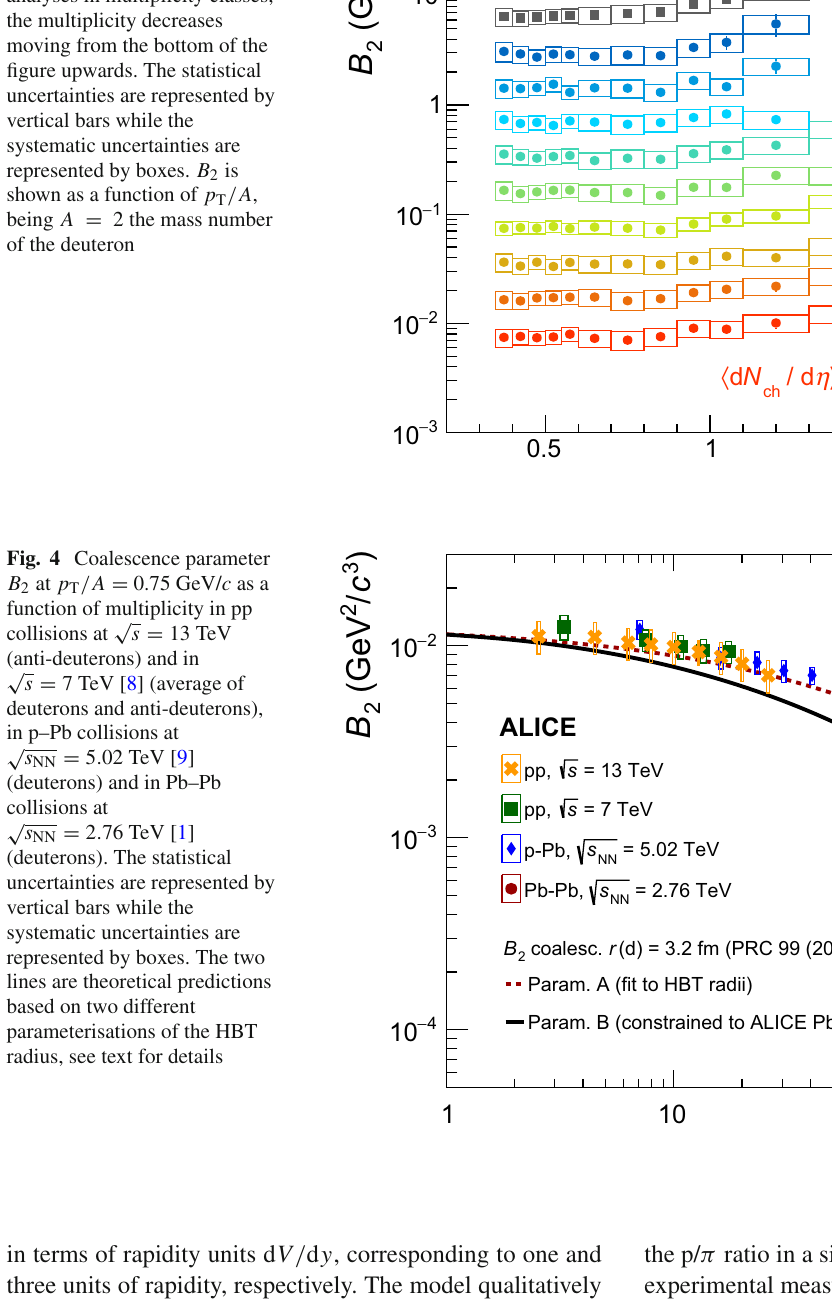
Fig. 3 Coalescence parameter B 2 for anti-deuterons for different multiplicity classes (circles) and for INEL > 0 collisions (squares). For the analyses in multiplicity classes, the multiplicity decreases moving from the bottom of the figure upwards. The statistical uncertainties are represented by vertical bars while the systematic uncertainties are represented by boxes. B 2 is shown as a function of p T / A , being A = 2 the mass number of the deuteron